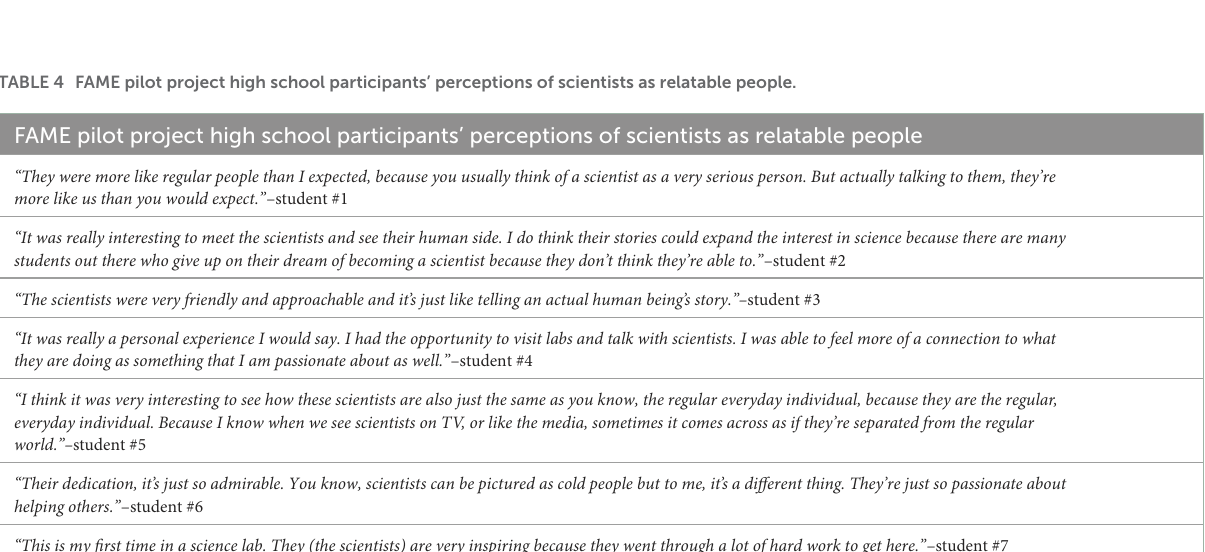
FIGURE10 FAME pilot project High School Youth Reflection data.